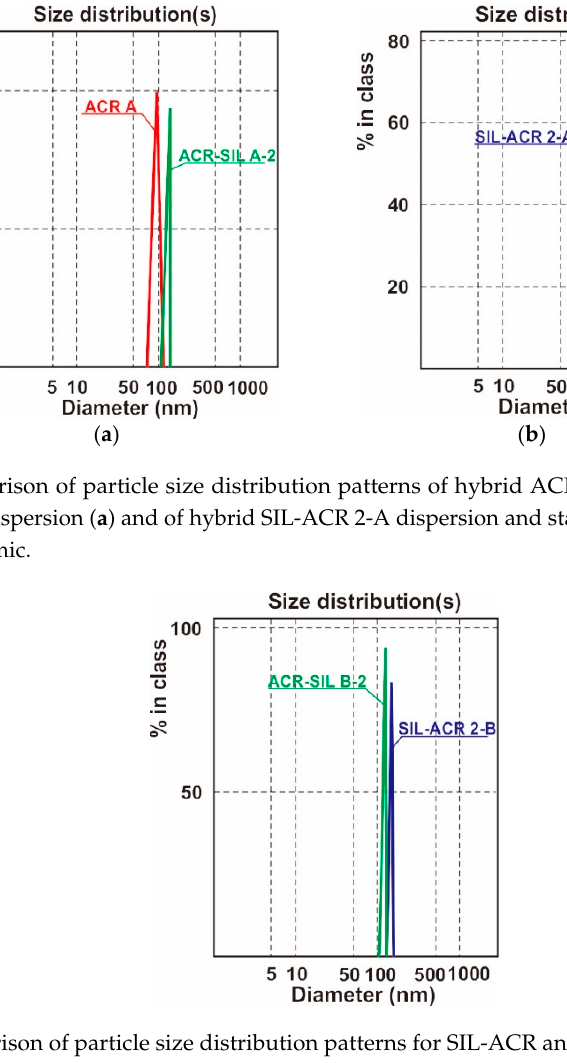
Figure 4. Comparison of average particle size of SIL and ACR dispersions and hybrid SIL-ACR and ACR-SIL dispersions. Coatings 2018 , 8 , x FOR PEER REVIEW